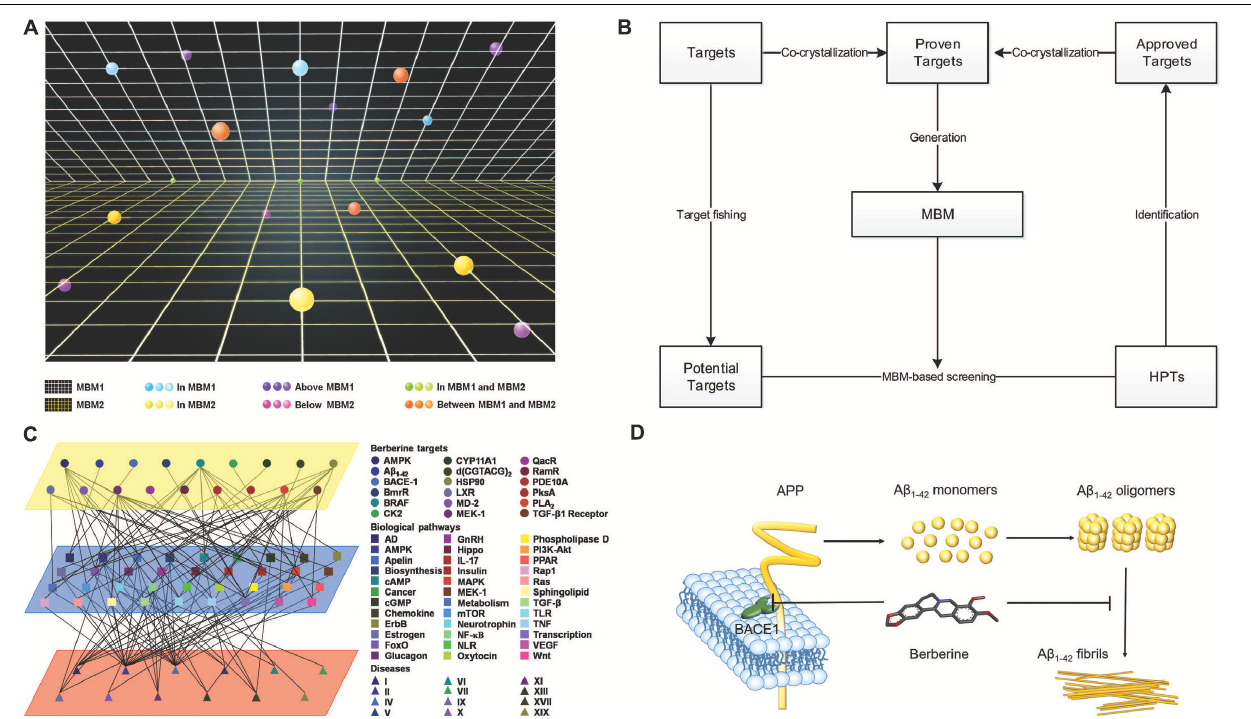
FIGURE 6 | Multi-target binding motifs (MBM)-based network pharmacology. (A) Drug-target space. Two-dimensional plans and circles correspond to MBMs and targets, respectively. Color-coding is given according to the spatial relationship between drug-MBMs and targets. (B) The workflow of MBM-based screening. (C) Network pharmacology obtained for berberine. A network view of berberine is generated by mapping drug-target networks onto biological networks on the basis of KEGG pathway database. Circles, squares, and triangles represent targets, biological pathways and diseases, respectively. Diseases are classified according to the International Classification of Diseases 10th Revision. Color codes are given in the legend. (D) The underlying mechanisms of berberine against AD. Berberine prevents the aberrant production and aggregation of A β 1 - 42 in the pathogenesis of